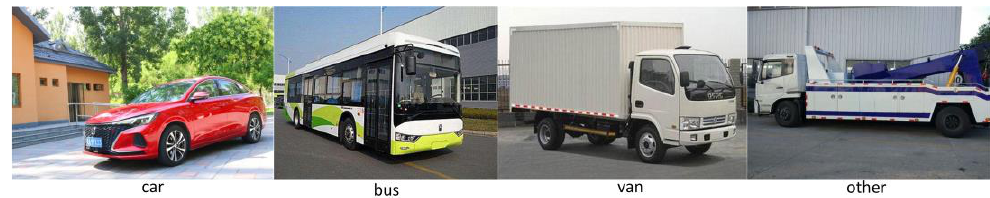
Figure 7. Types of images in the dataset, including cars, buses, vans, and other vehicles.